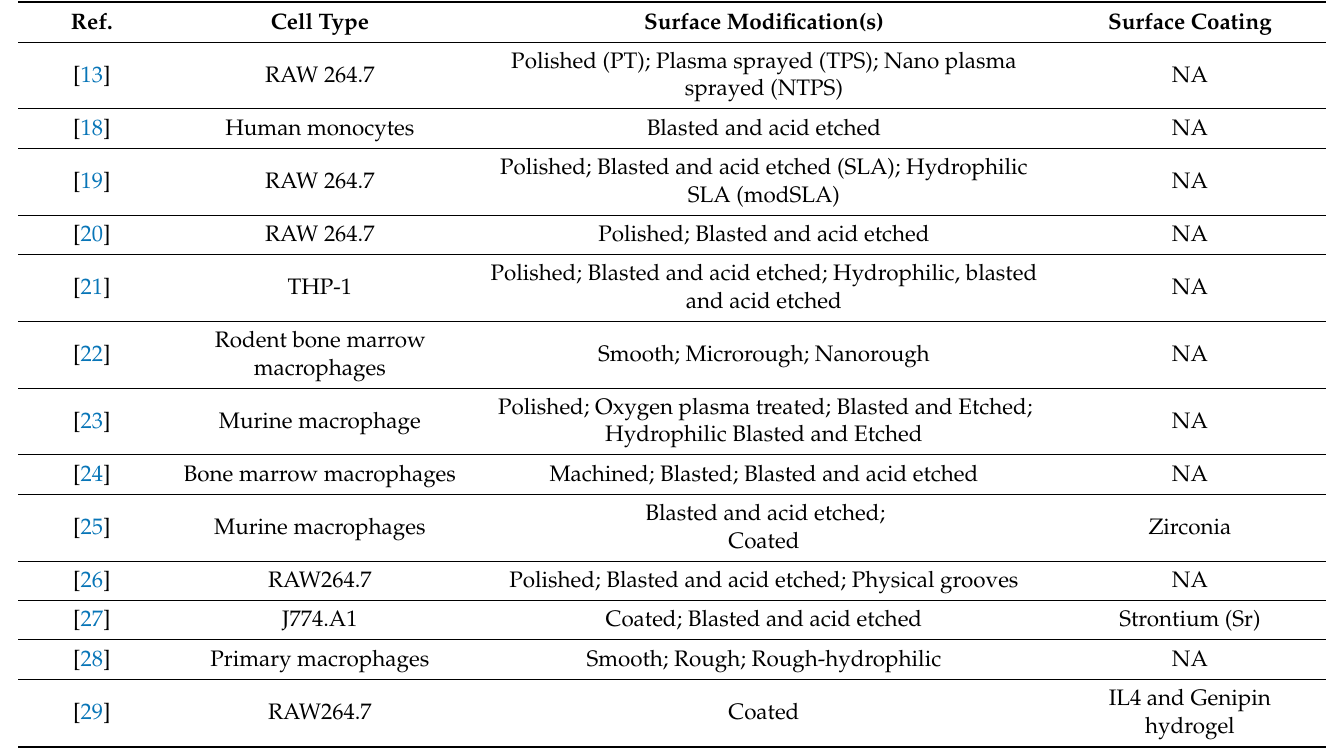
Table 2. Summary data (Cell type, Surface Modification and Surface Coating) of studies included in review. Both primary bone-derived macrophages as well as commercial cell-lines were included for analysis. Given the articles were selected based on the titanium eliciting an immune (macrophage) response, surface modification techniques were relatively evenly split between subtractive (41%) additive (28%) and coated (44%). Note that some studies included more than one methodology. (NA) not applicable in this study, (NR) not recorded in this